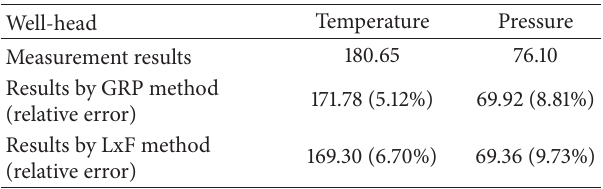
Table 5: Comparative results of the well head at 1200